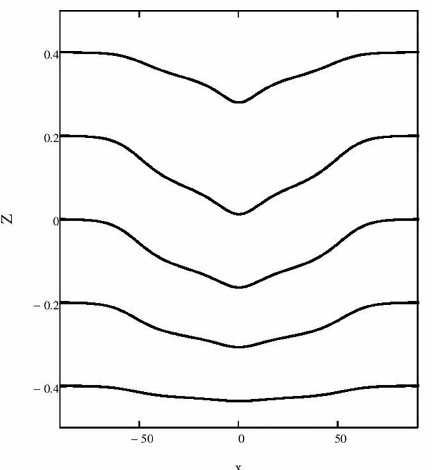
Figure 3. Streamlines for the two-humped solitary wave: α = − 1 . 39; A = 0 . 1885. 0